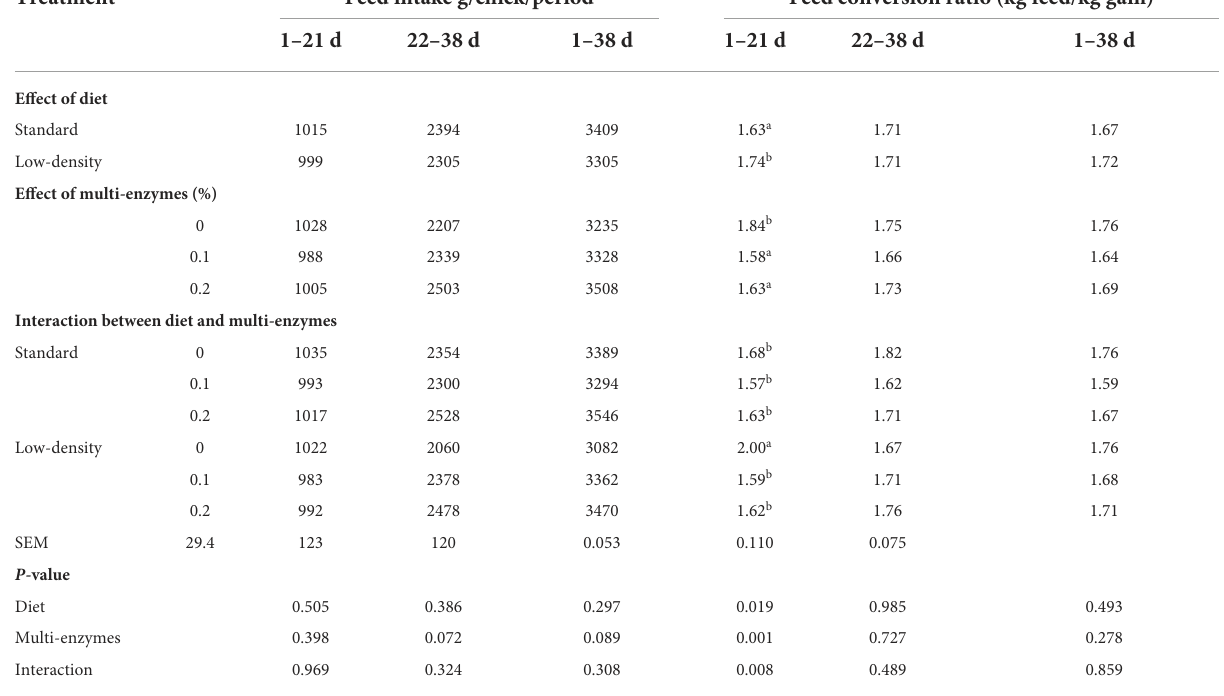
TABLE 3 Feed intake and feed conversion ratio of broilers fed standard and low-density diets supplemented with different concentrations of multi-enzymes from 1 to 38 days of age.